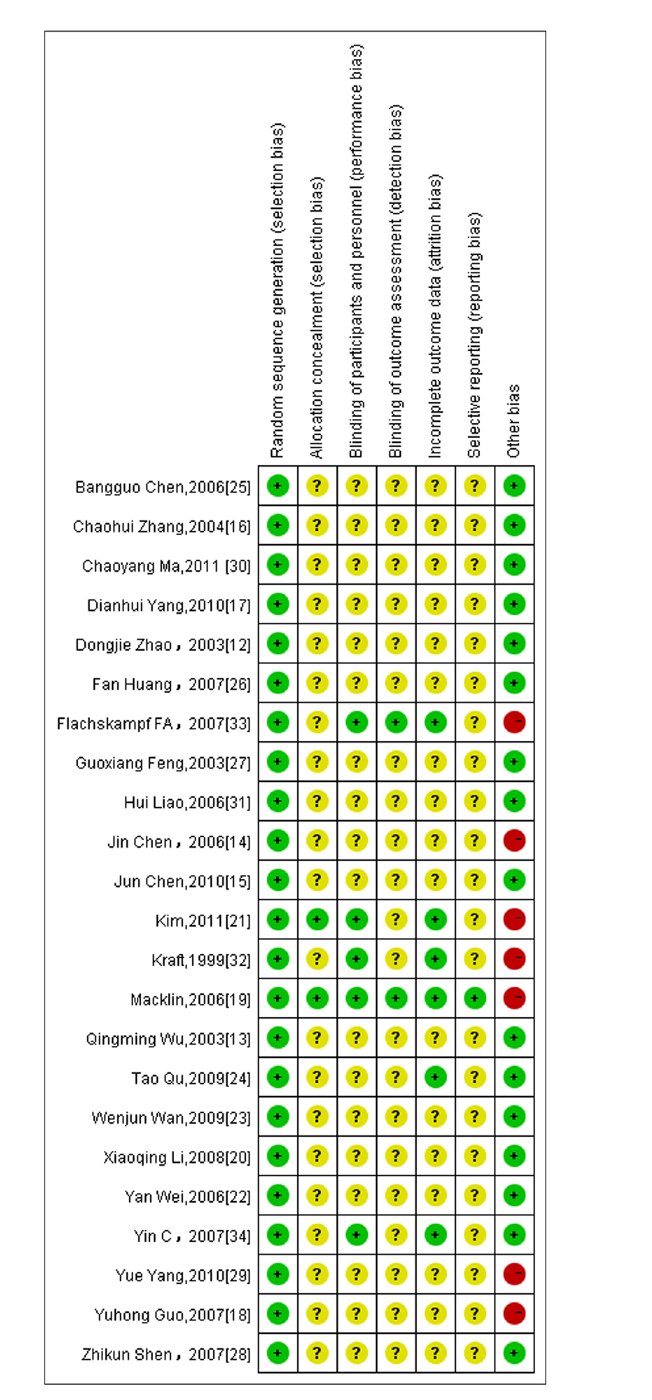
Fig 7. The risk of bias assessment for each included